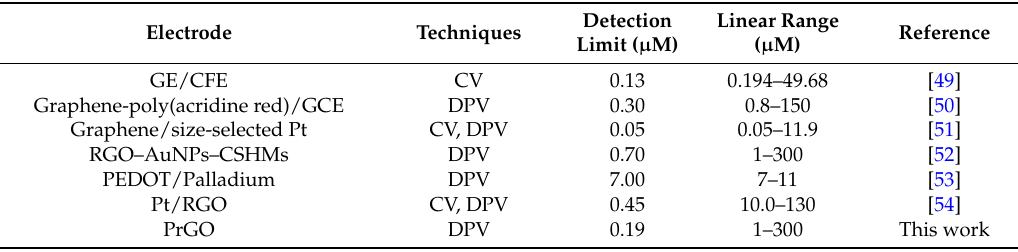
Table 2. Analysis data of uric acid in real samples ( n = 3).